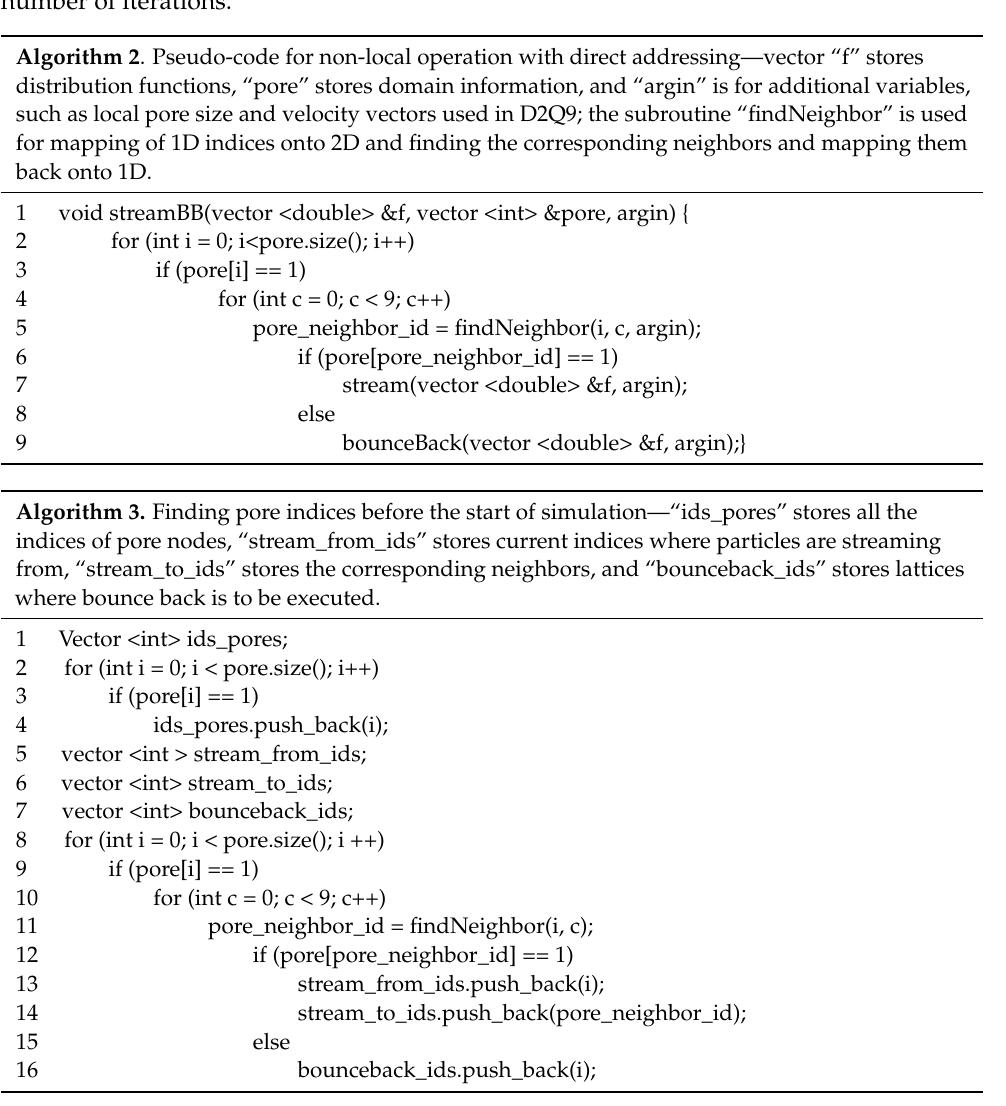
Algorithm 2 . Pseudo-code for non-local operation with direct addressing—vector “f” stores